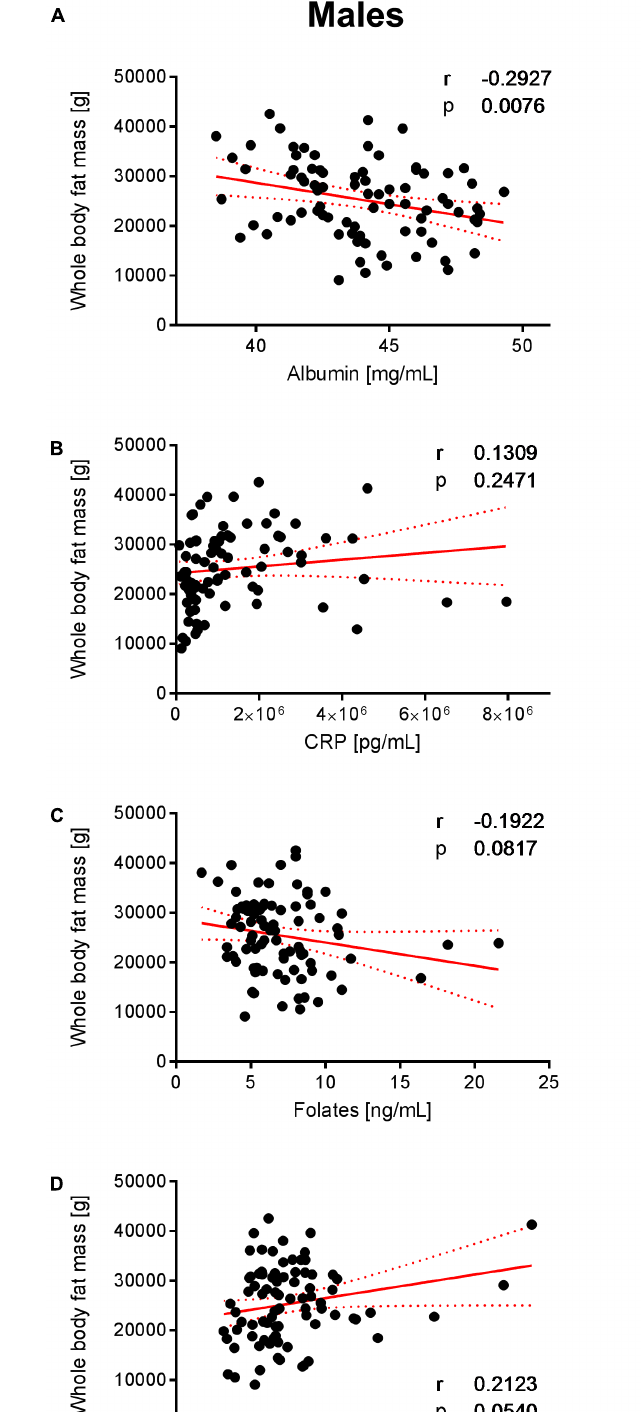
Frontiers in Physiology |